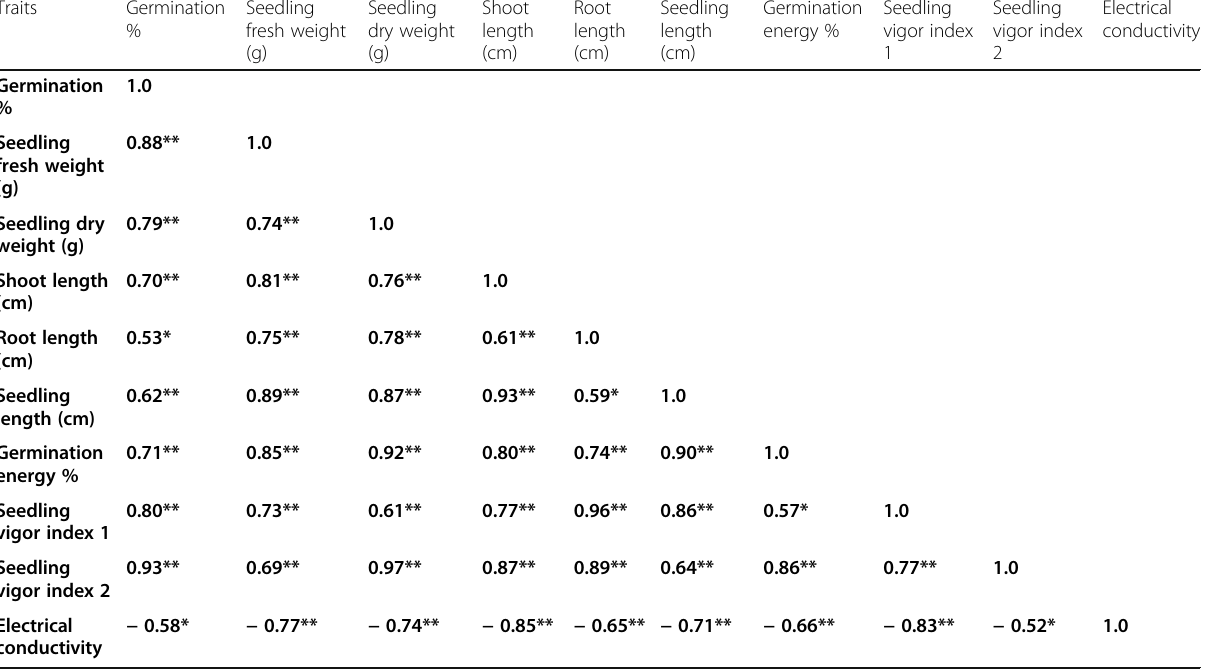
Table 3 Correlation coefficients among M 2 lentil seedling traits under control Traits